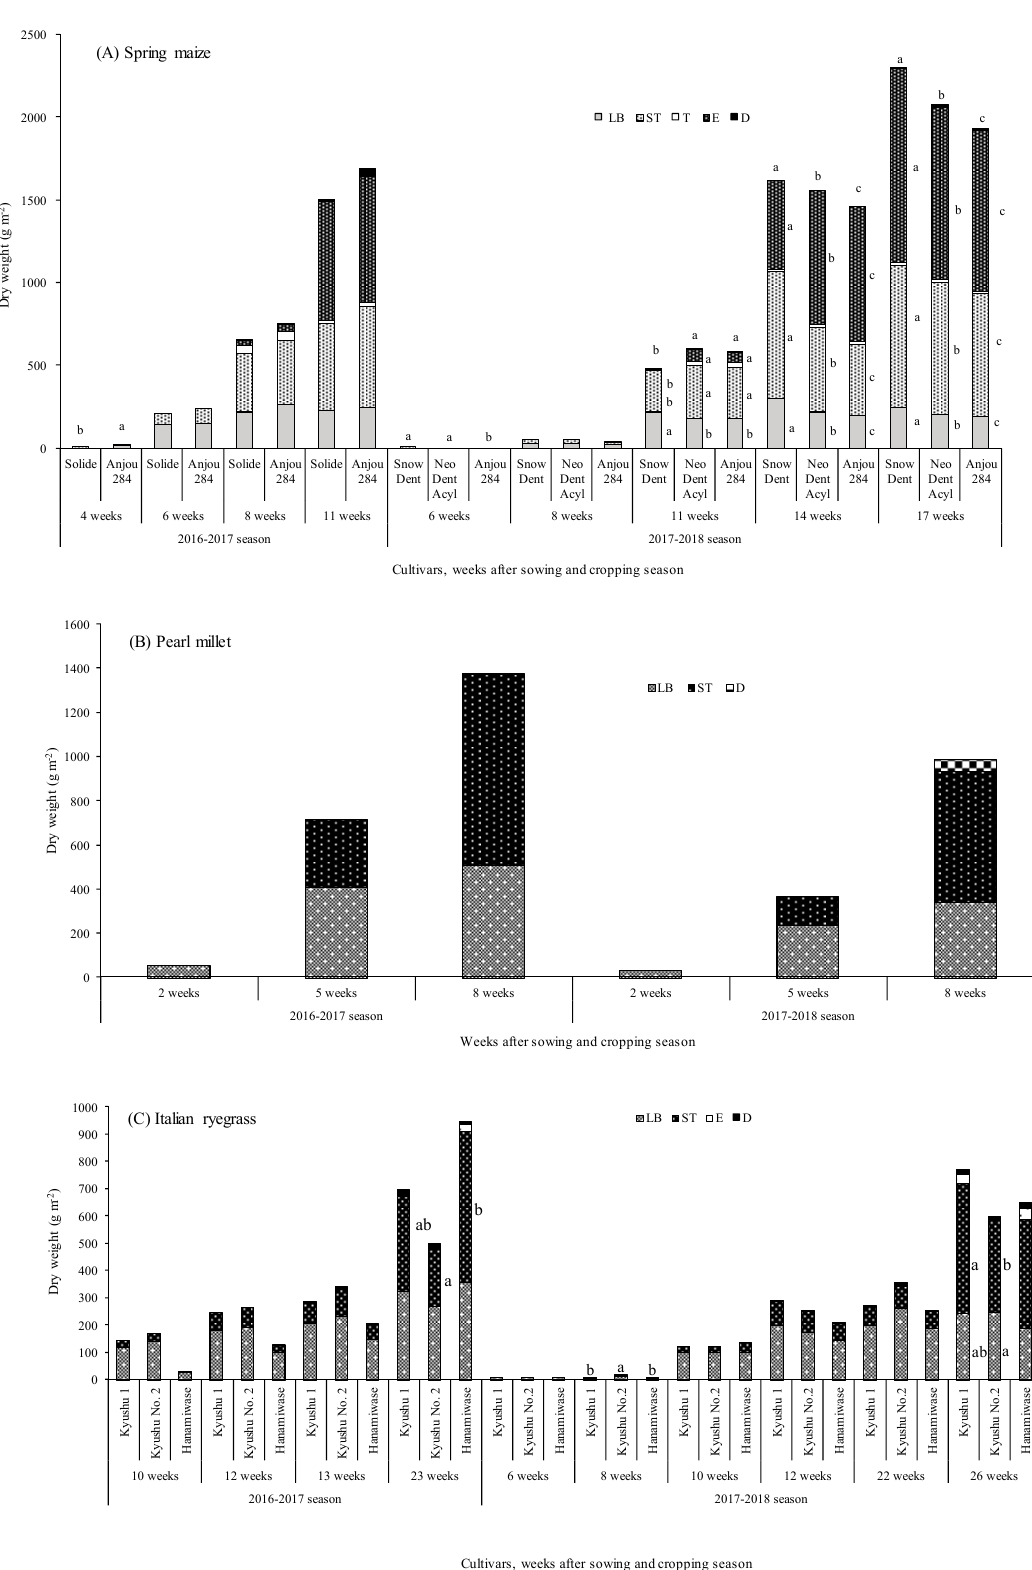
Figure 4. Changes in dry weight of plant fractions in spring maize ( A ), pearl millet ( B ) and twice-cut Italian ryegrass ( C ) in two cropping seasons. Plant fraction: Leaf blade (LB), Stem inclusive of leaf sheath (ST), Ear (E), Tassel (T) and Dead leaf (D). a–c p < 0.05 among cultivars in the same cropping season and date.